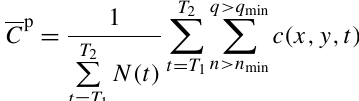
218 cm − 3 for Cu-NCP. However, more aerosols are activated in Cu-TP compared to Cu-NCP, and the p mean of the CDNC increases from 0.80 to 415 cm − 3 for Cu-TP. Although the CAPE is similar for Cu-TP and Cu-NCP, the p mean of CDNC in Cu-TP is higher than that in Cu-NCP with the same [ N a